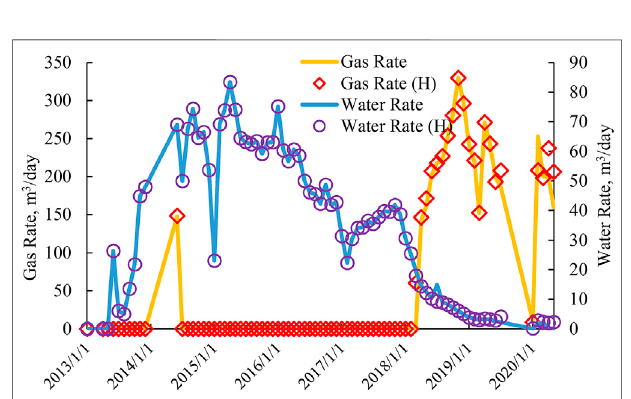
FIGURE 4 | History matching of daily gas and water production of well